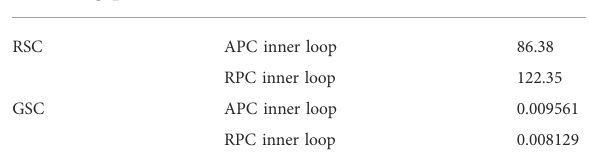
TABLE 4 The MCCM of oscillation